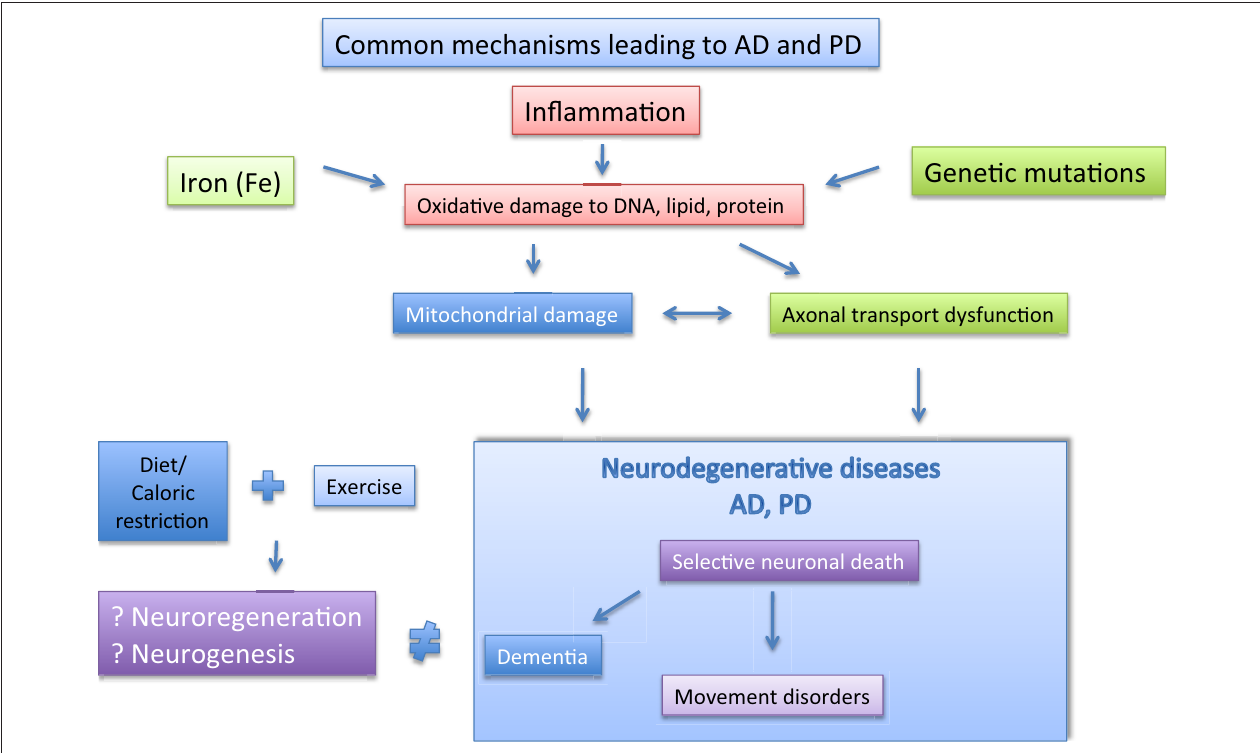
Figure 2 | The major player implicated in AD and PD are depicted here. The possible pathological factor (boxed), and likely interactions between them are shown. Separately, Caloric restriction and exercise may help to prevent AD and PD via neuroregeneration and